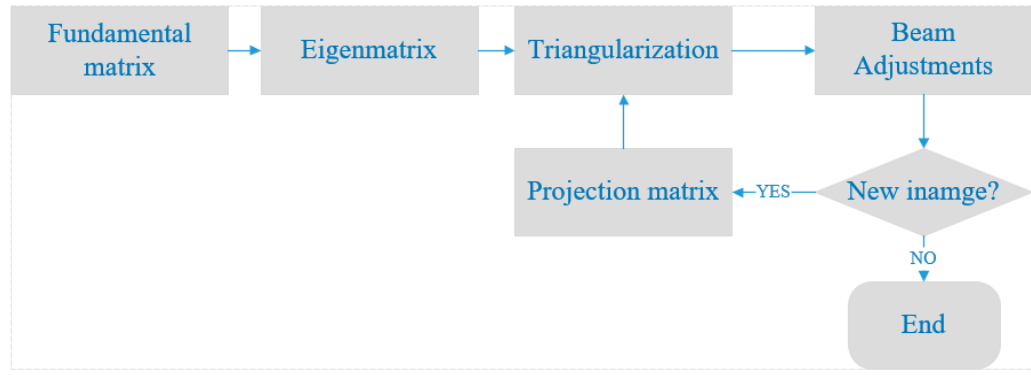
Figure 3. The schematic of sparse reconstruction for two images.